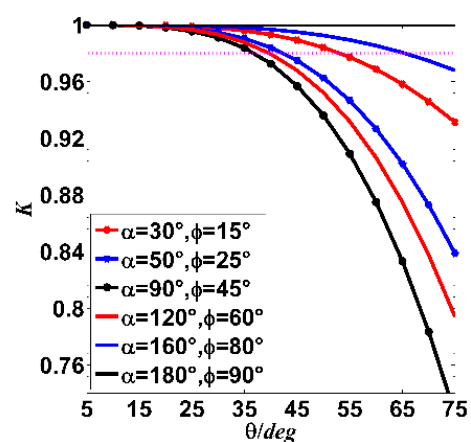
Figure 3. The relationship between the contrast of the two-beam interference light field and the incident angle under the optimal polarization incident condition. In the case of non-coplanar interference of two beams, the contrast loss caused by the increase in the incident angle is inevitable.